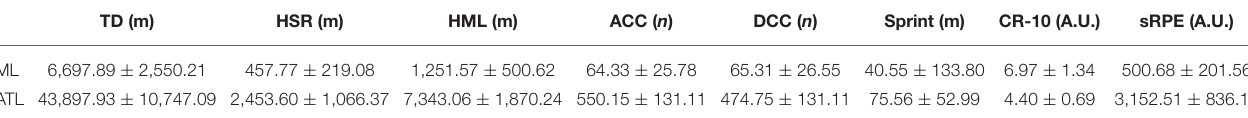
TABLE 3 | Description (mean ± SD) of accumulated training load and match load (ML) demands.